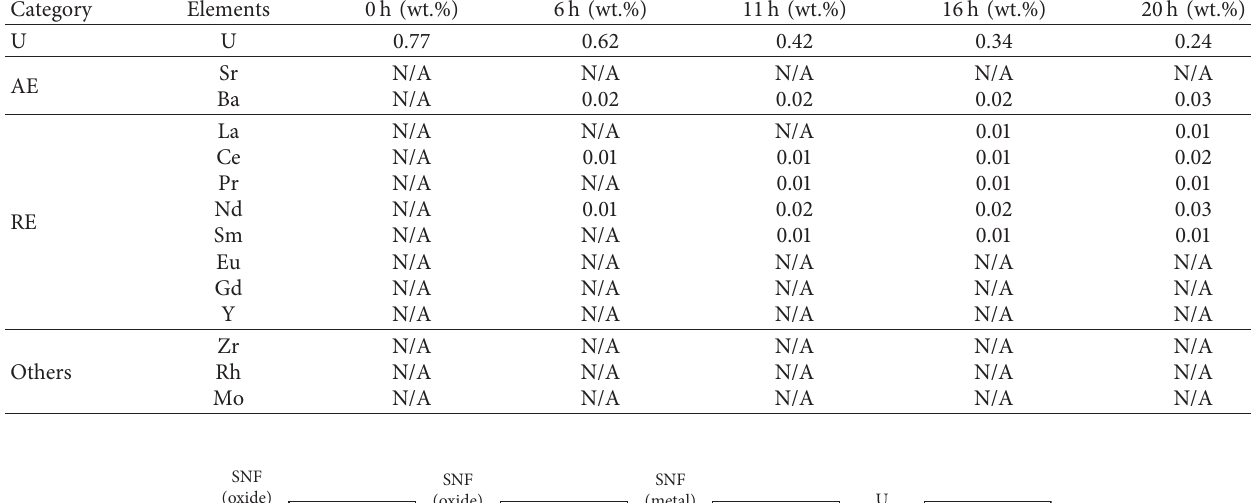
Table 3: ICP-AES analysis of the LKU salt during the SSF pellet